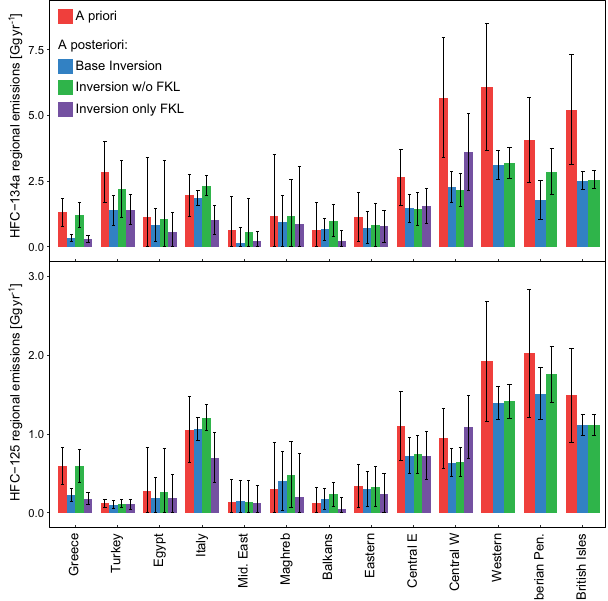
Figure 10. Regional annual emission estimates of 2013. The a pri- ori of our BASE inversion is shown in red. A posteriori results are shown for the BASE inversion (blue), the inversion excluding Fi- nokalia (S-NFKL, green) and the inversion using only observations from Finokalia (S-OFKL, purple). Error bars represent the 95% confidence levels. Note that for the inversion based on Finokalia observations alone (S-OFKL) the inversion domain was cropped in the west and no a posteriori emissions for the western part of the domain were estimated.